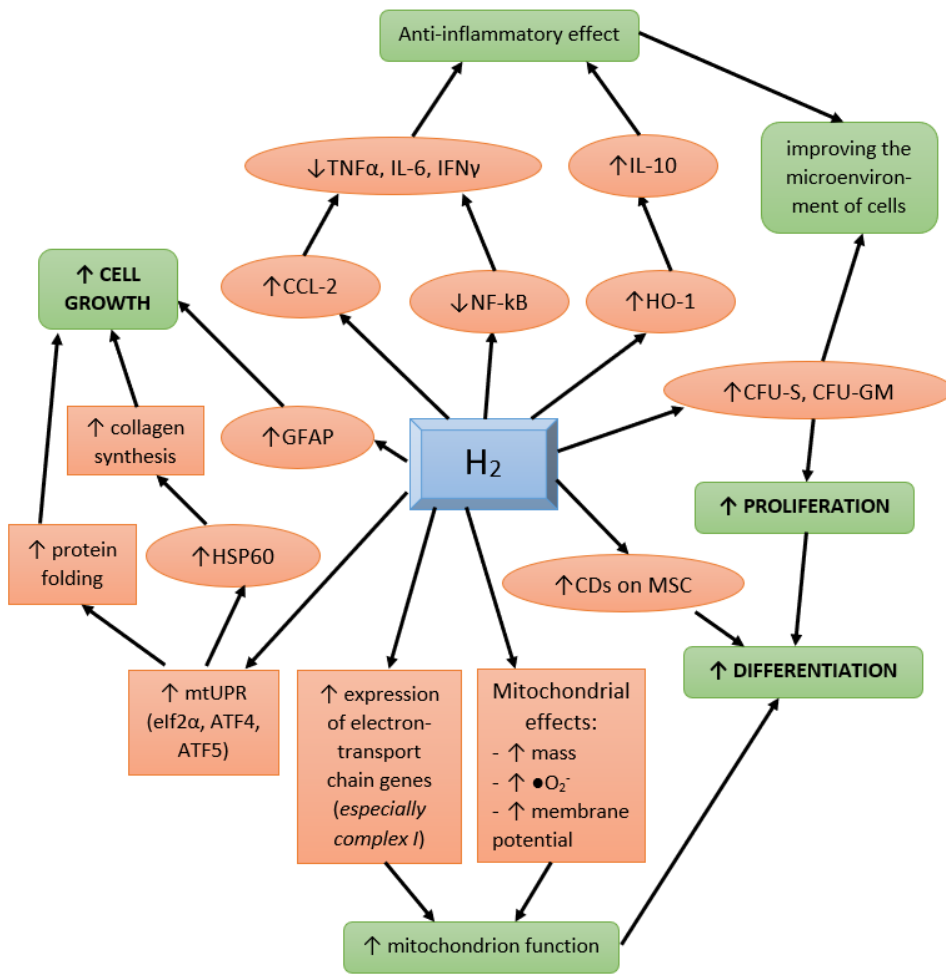
Figure 6. The influence of molecular hydrogen on the state of stem cells. This diagram shows the molecular regulators (indicated by red clouds) and the cellular effects caused by them (green blocks) that are significant for the functioning of stem cells. Abbreviations: HSP–heat shock protein, CFU–colony-forming unit, HO–heme oxygenase, TNF–tumor necrosis factor, IFN–interferon, CD–cluster differentiation marker, MSC–mesenchymal stem cell, GFAP—glial fibrillary acidic protein, IL–interleukin.